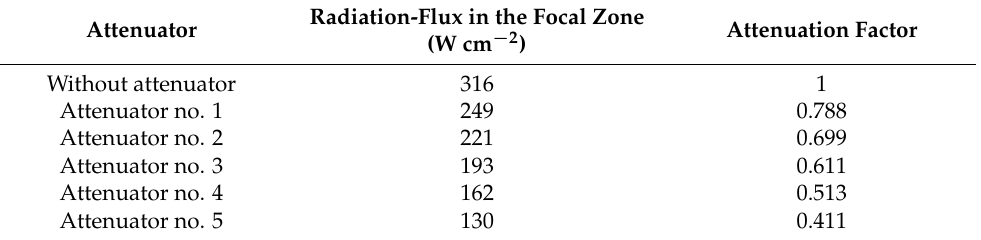
Table 3. Radiation-flux attenuation factors obtained with five different